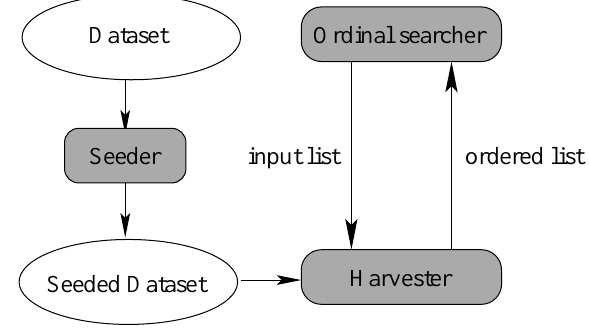
Figure 14. Relationship among the main components (shaded blocks). Ordinal searcher Seeded Dataset